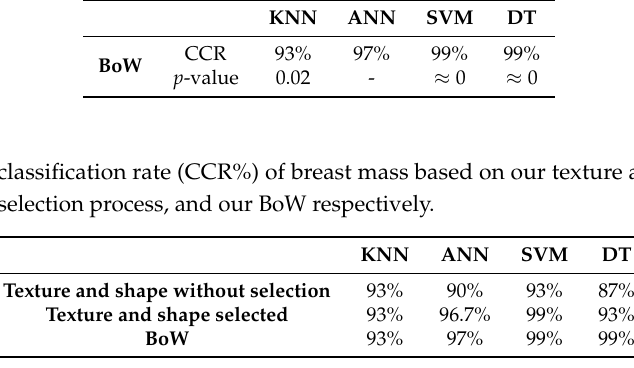
Table 11. Correct classification rate (CCR%) and p -value of breast mass based on our Bag of words.